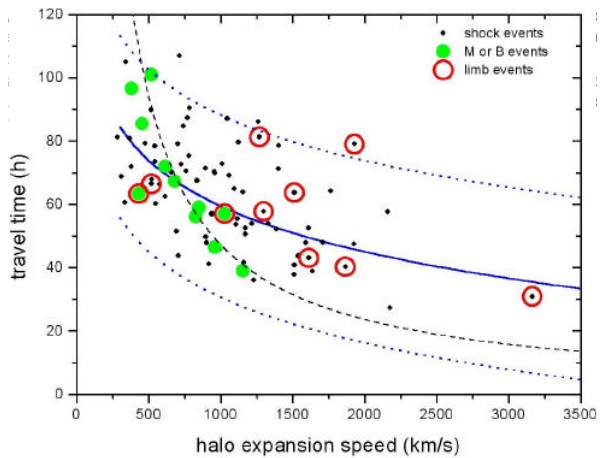
Figure 10. The ICME travel times plotted vs the halo expansion speed V exp for the 75 usable cases of unique CME-shock correlations. The travel time T tr is defined by the CME’s first appearance in C2 images and the shock arrival at 1 AU. The solid blue line is a least square fit curve to the 75 data points, the fit function being T tr = 203 – 20.77 * ln (V exp ). The standard deviation from the fit curve is 14 hours. The two dotted lines denote a 95 % certainty margin of 2 standard deviations. The thin dashed line marks the calculated travel time for a constant radial propagation speed (kinematic approach) inferred from the observed expansion speed according to relation (1). The green dots denote ICMEs without shock signatures, i.e. magnetic clouds (M) and plasma blobs (B). These points were not used for the fit.